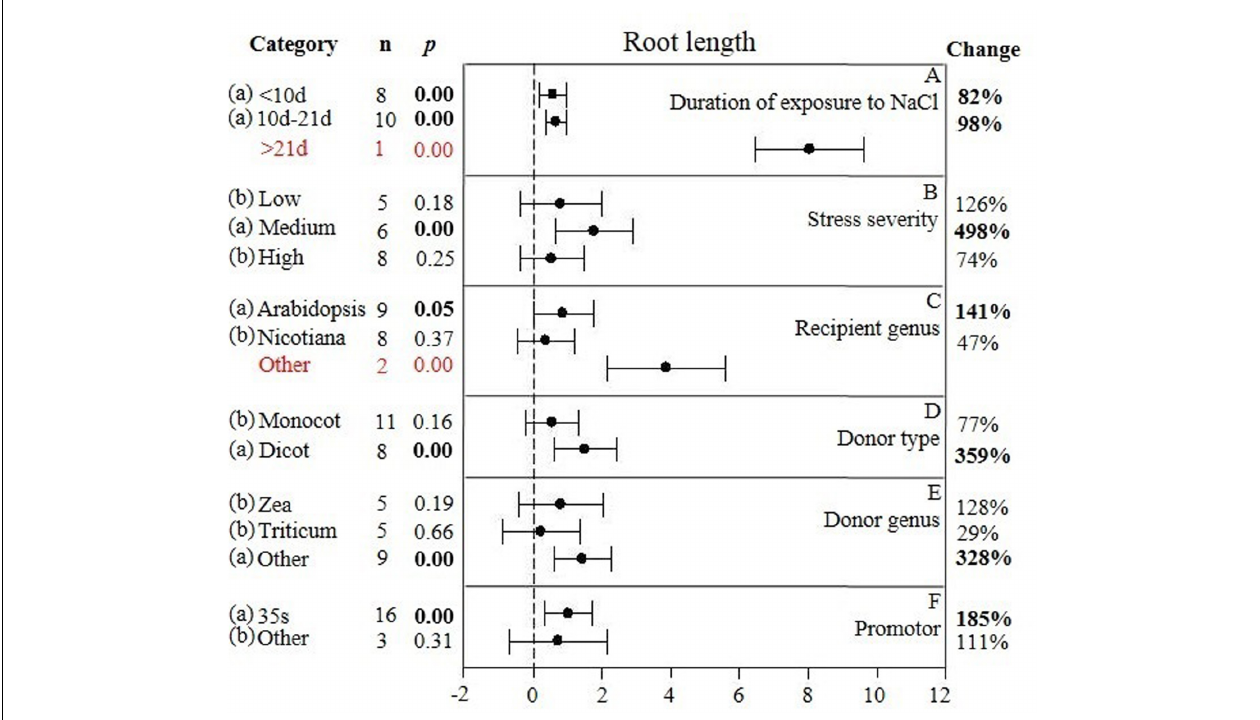
FIGURE 3 | Weighted summary effect sizes (ln R ) and 95% CIs showing how moderator variables affect the extent to which CIPK transformation modifies root length. (A) Duration of exposure to NaCl, (B) Stress severity, (C) Recipient genus, (D) Donor type, (E) Donor genus, and (F) Promotor. A p ≤ 0.05 indicates that the moderator level was significantly different than zero; n stands for the number of